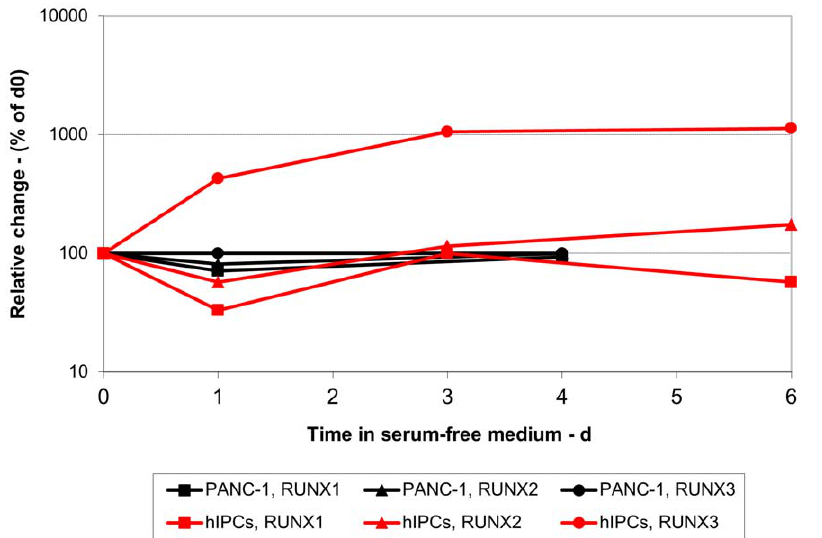
Figure 4. Kinetics of changes in expression of RUNX genes. hIPCs and PANC-1 cells were either cultured in serum-containing medium (t=0) or for the indicated times in serum-free medium. RNA was extracted and qRT-PCR performed as described in Materials and Methods. Results are presented as % change in mRNA levels of the three RUNX genes as a function of time in serum-free medium.